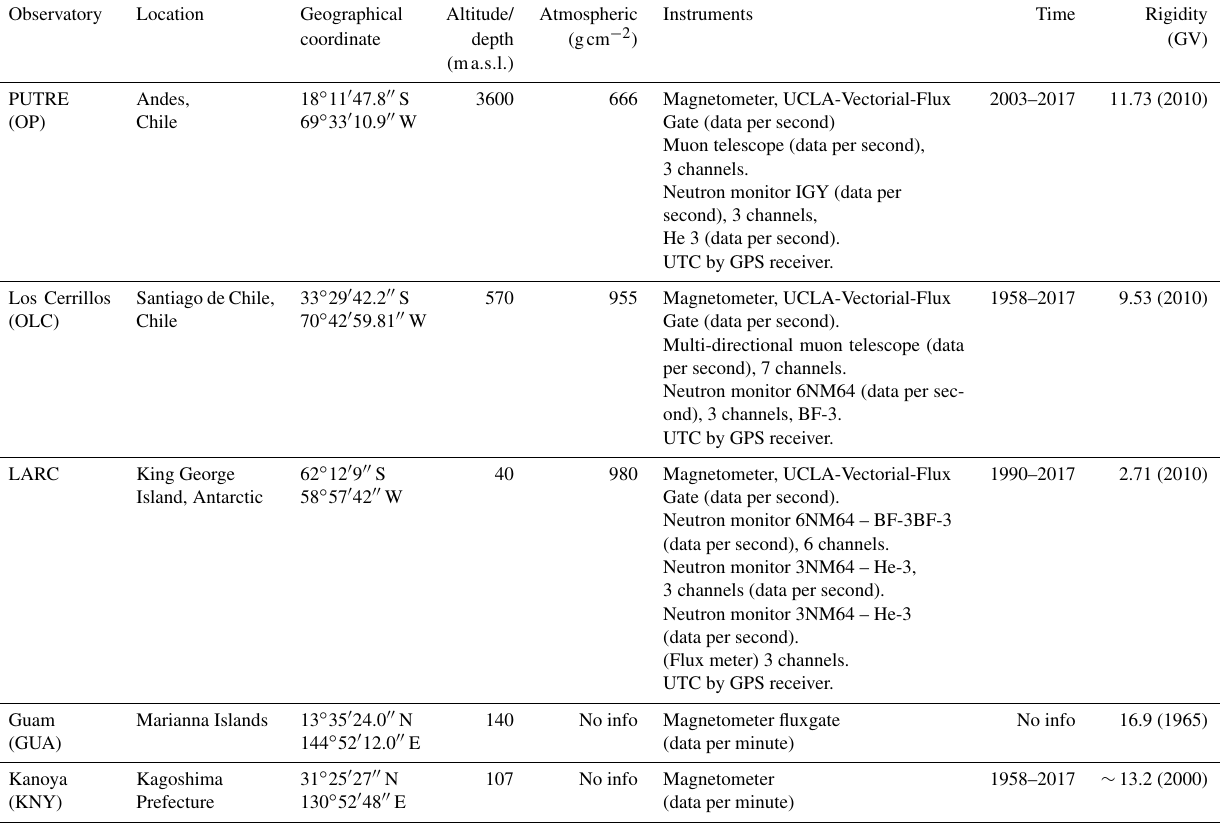
Table 1. Technical specifications of the Chile, Guam and Kanoya stations used (data from Anand et al., 1968 and Cordaro et al., 2012). Observatory Location Geographical Altitude/ Atmospheric Instruments Time Rigidity coordinate depth (gcm − 2 ) (GV) (ma . s . l . ) Magnetometer, UCLA-Vectorial-Flux Gate (data per second) Muon telescope (data per second), 3 channels. Neutron monitor IGY (data per second), 3 channels,